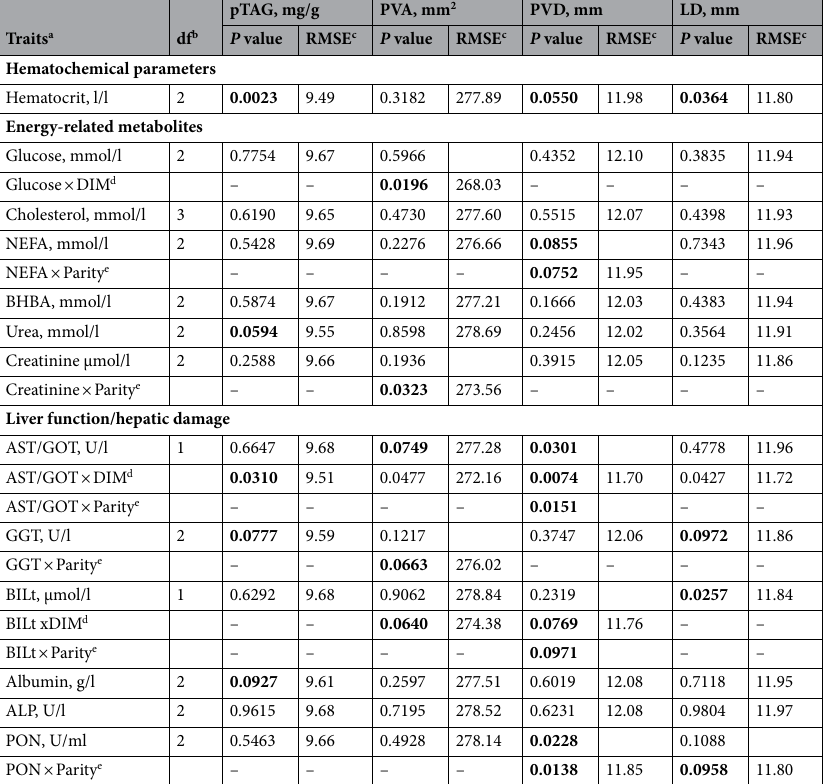
(ROMt) interacted with parity in relationship to portal vein parameters: at increasing values of PVA ( P = 0.0934) and PVD ( P = 0.0916), the concentrations of ROMt increased in multiparous cows and decreased in primiparous cows (Fig. 4a, b). Furthermore, the increase in ROMt increased LD ( P = 0.0697; Fig. 4c). Increasing concentra- tions of advanced oxidation protein products (AOPP), especially the 2nd, 3rd, and 4th classes, were associated with an increase in PVA in multiparous cows, whereas the opposite trend was observed in primiparous cows with PVA values decreasing as AOPP concentrations increased ( P = 0.0845; Fig. 4d). At low concentrations of ferric-reducing antioxidant power (FRAP), PVD values were higher ( P = 0.0661; Fig. 4f). Regarding the pTAG indicator, the interaction with parity revealed opposite trends at decreasing con- centrations of FRAP, with pTAG content increasing in multiparous cows and decreasing in primiparous cows ( P = 0.0696; Fig. 4e). Finally, high thiol groups concentration showed a decrease in PVA ( P = 0.0339; Fig. 4g), whereas for PVD and LD, the interaction with parity revealed a different trend: with increasing thiol groups concentration PVD/LD measurements increased in multiparous cows, while in primiparous cows PVD decreased and while the LD measurement remained essentially the same ( P = 0.0871 and P = 0.0464, respectively; Fig. 4h, i).